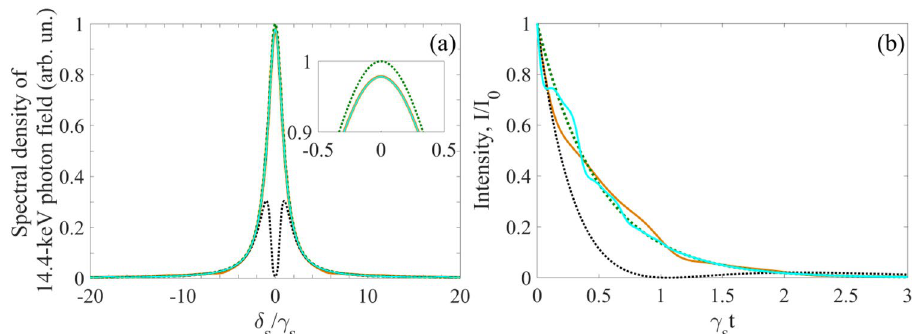
Figure 4. (Color online) Spectrum (a) and waveform (b,c) of the Lorentzian single-photon wave packet 0 ) vibrated with frequency � 5 , T transmitted through the 57 Fe absorber ( T M e = = 18 (as in Fig. 3) in the laboratory reference frame for SMS ( γ corresponding to �/γ 21 = 0 and ϑ 2 , respectively) and for RMS ( γ π red lines for ϑ S = γ 21 , orange and purple lines for ϑ = = = 2 , respectively). The green dotted lines correspond to the incident photon, whereas the black dotted ϑ π = (cid:31) and solid lines—to the SMS and RMS photon, respectively, transmitted through the motionless absorber. The (cid:31) blue, red, and green lines correspond to those in Figs. 2 and 3. The blue, red, purple, orange and black curves 2 L ) E S (ω S , z are plotted as the normalized function in Eq. (13) for (a) and as the function I out ( t )/ I 0 [where ˜ = ( 8 π) ] in Eq. (12) for (b,c) , with E S (δ S ) taken from Eq. (18) under the parameter values in Fig. 3. I 0 cE 2 0 ˜ = (cid:31) (cid:31) (cid:31) (cid:31) (cid:31)